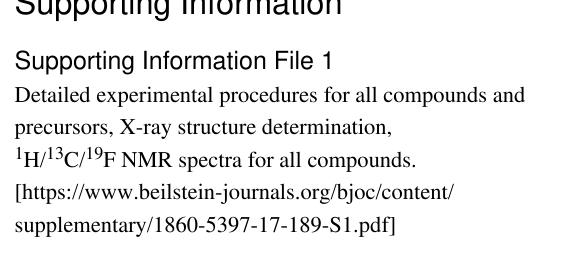
PIFA are used in 2,2,2-trifluoroethanol solution at 0 ° С over 24 h. The synthesized compounds represent a new class of